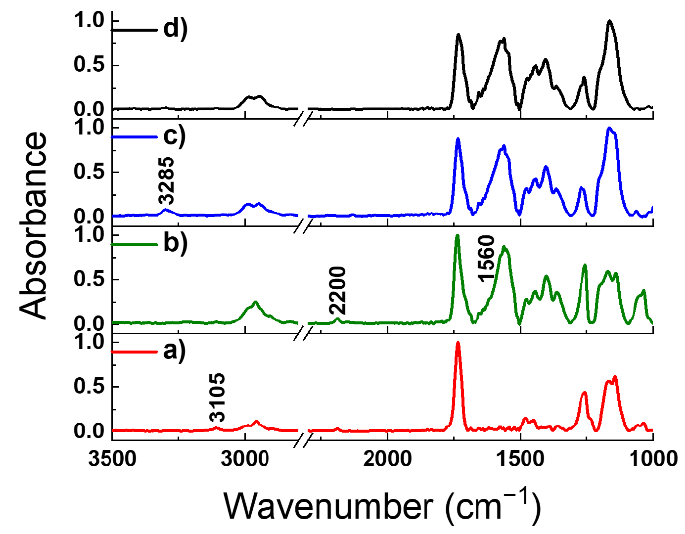
Figure 9. The comparison of normalized absorbance FTIR spectra of ITO-g-PMTM-co-PTPM brushes after metal-free SI-ATRP ( a ), oxidative polymerization of thiophene groups using FeCl 3 ( b ), acetylene group deprotection ( c ), and polymerization of pendant acetylene using Rh-based catalyst ( d ).